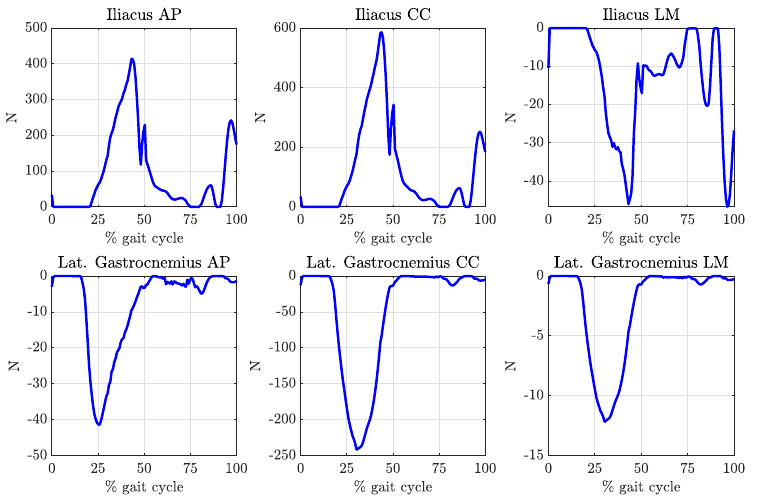
Figure A1. Temporal evolution of the components of the forces exerted by the iliacus and the lateral gastrocnemius throughout the gait cycle. AP: antero-posterior. CC: Cranio-caudal. LM: